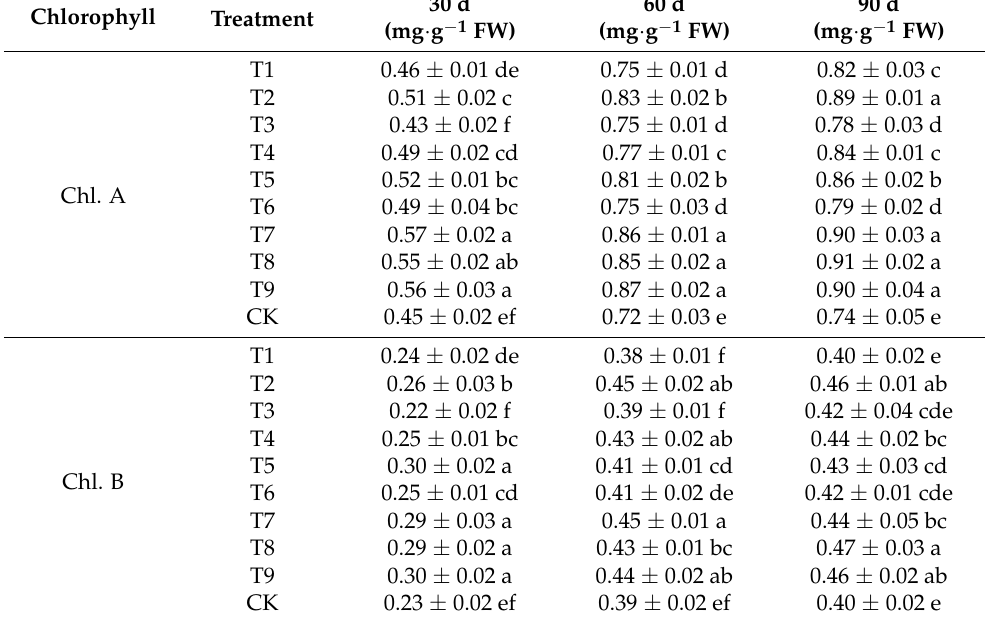
Table 1. Effects of different levels of nitrogen, phosphorus, and potassium on chlorophyll A and chlorophyll B